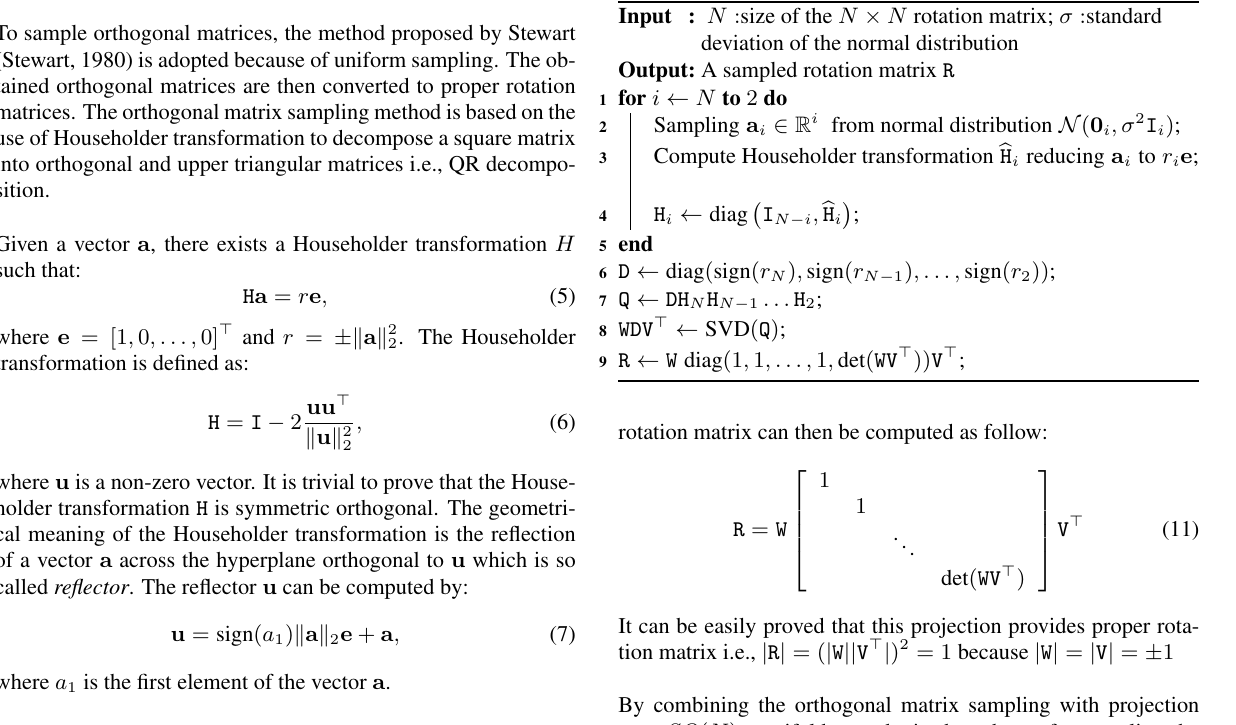
Algorithm 2: Random rotation matrix